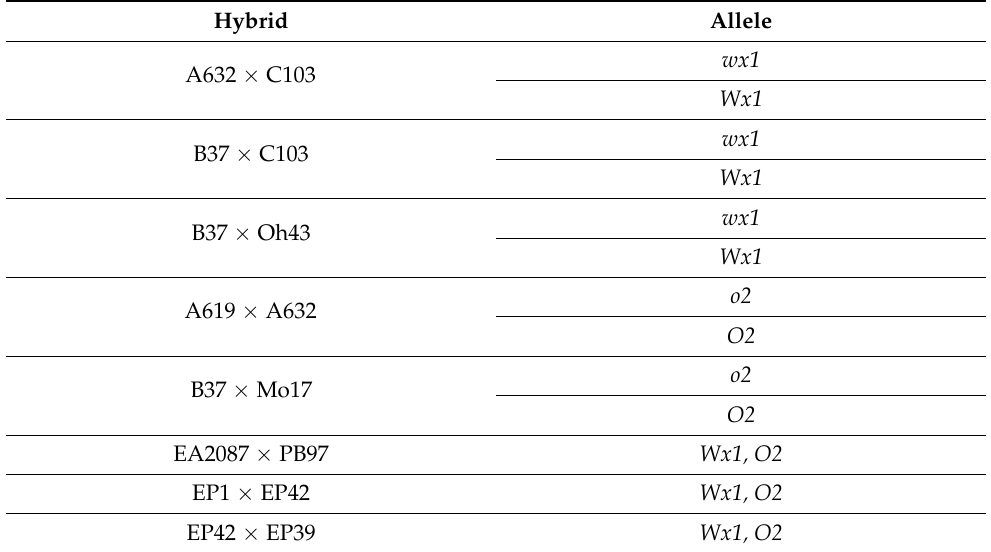
Table 1. Maize hybrids, with Dent grains homozygous for recessive mutants with high amylopectin ( waxy1, wx1 ) or quality protein ( opaque2, o2 ) and the respective wild-type isogenic hybrids, evaluated during two years in two locations of Pontevedra (Northwestern Spain), along with three Flint hybrids, for grain, flour and bread